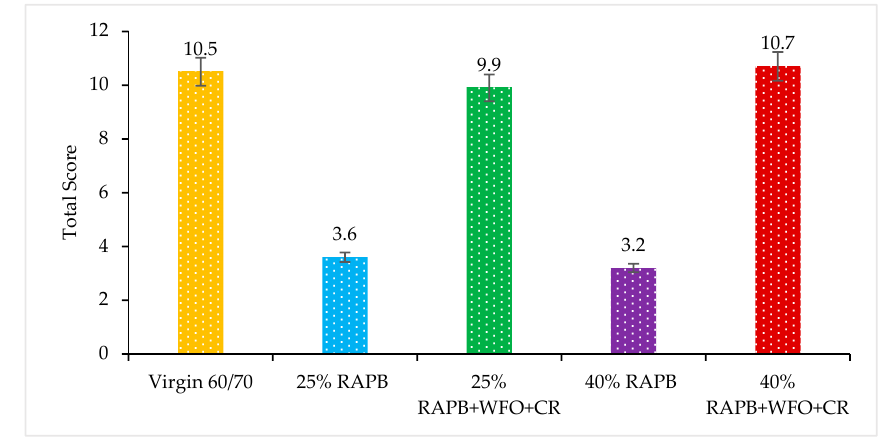
Figure 6. Overall score of the bleeding result for all asphalt binders.